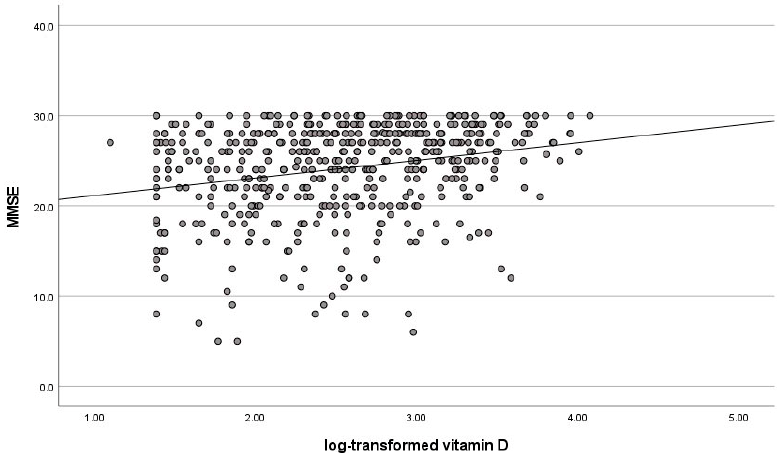
Figure 1. Univariate linear regression analysis between log-transformed Vitamin D and MMSE score in all subjects.